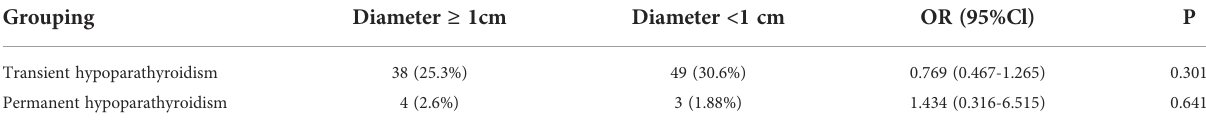
TABLE 4 The diameters of thyroid cancer nodules and risk of